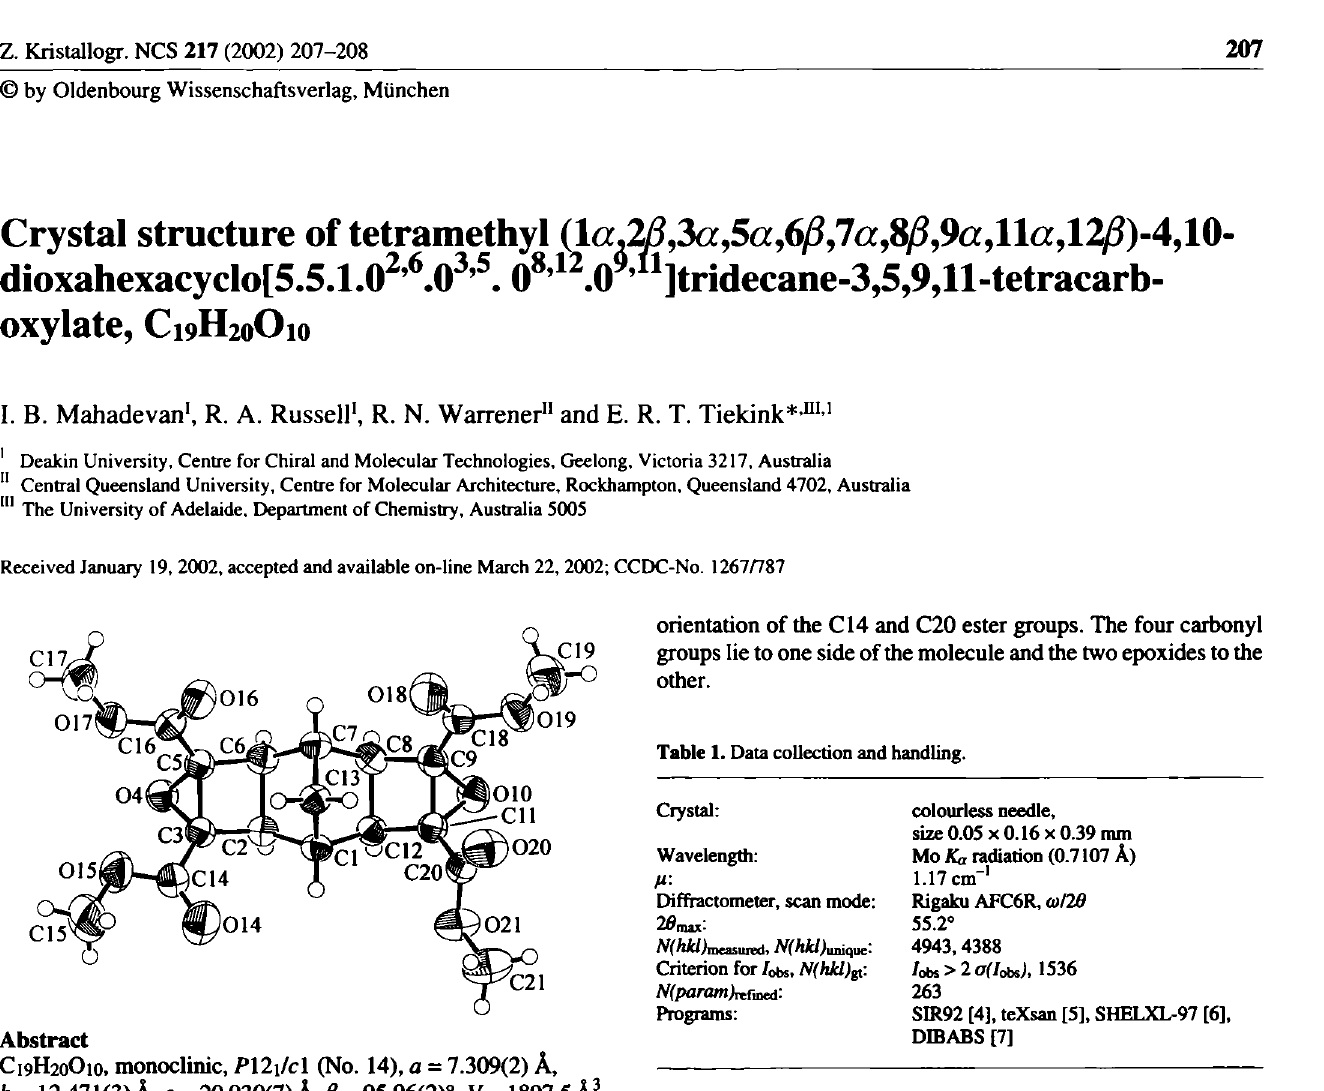
Table 2. Atomic coordinates and displacement parameters (in Â 2